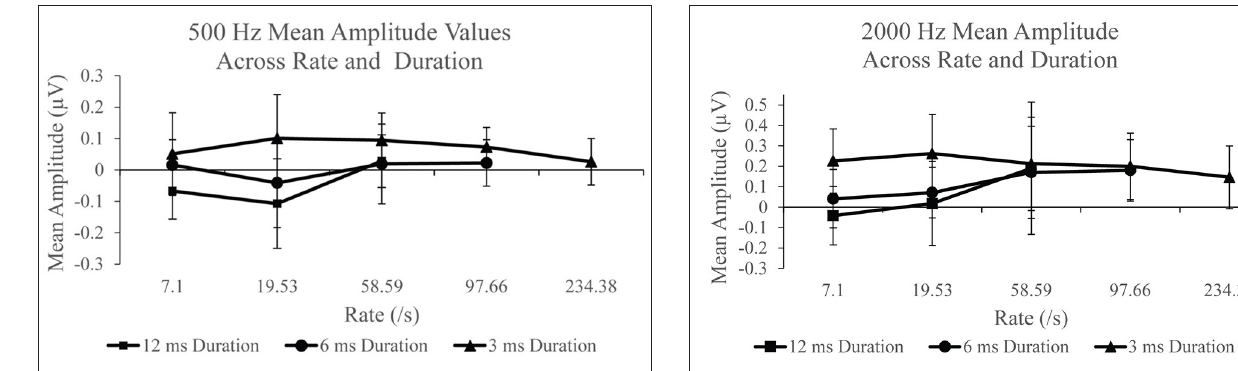
to 234.38/s (mean = 0.026 µ V). For the long duration stimuli, a